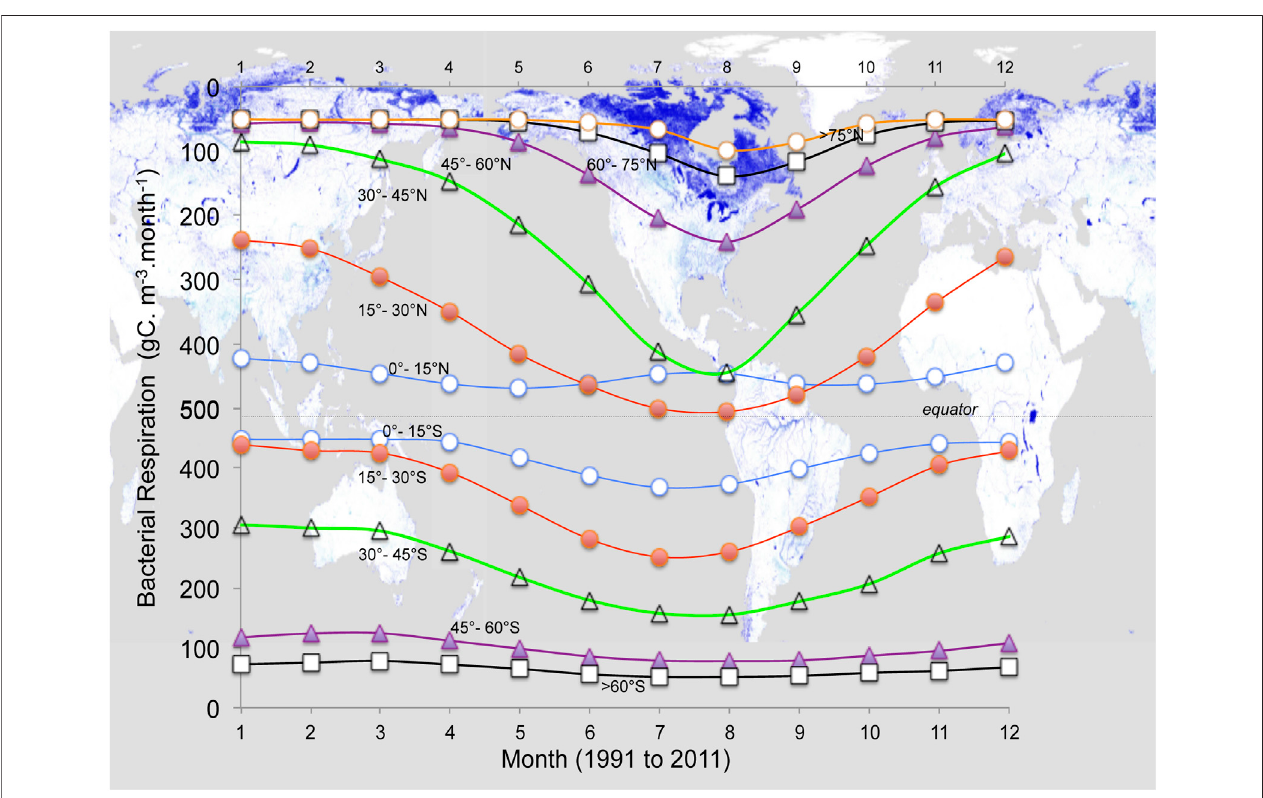
FIGURE 4 | Globalfreshwater bacterial respiration in each 15 ° latitude bandwidth. The underlying maps ofglobalfreshwater (Modi fi ed from Pekelet al., 2016) with the 15 ° latitude bandwidths of bacterial respiration (BR) overlayed. Notice BR in the Northern Hemisphere is similar to BR around the equator that also aligns with the largest surface freshwater area (also see Table 1 ). This combination is the reason the North Hemisphere outgases the South Hemisphere.